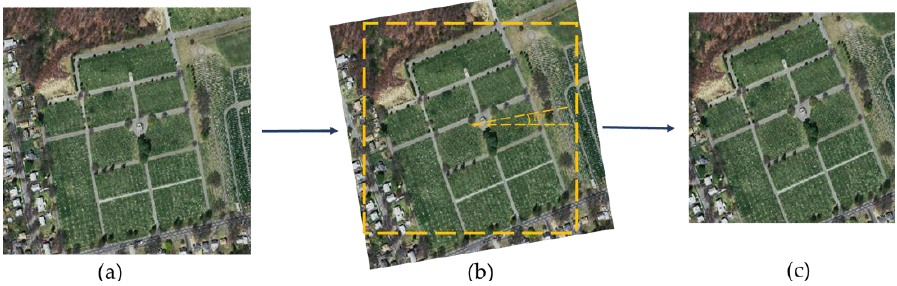
Figure 2. Example of data enhancement applied by image rotation and cropping. ( a ) is the original image; ( b ) is the result after image rotation; ( c ) is the result after image cropping.